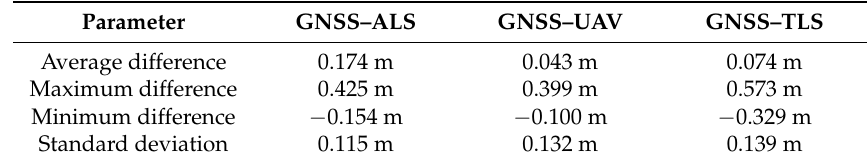
Table 6. Accuracy evaluation parameters of acquired materials for the first calculation scenario.